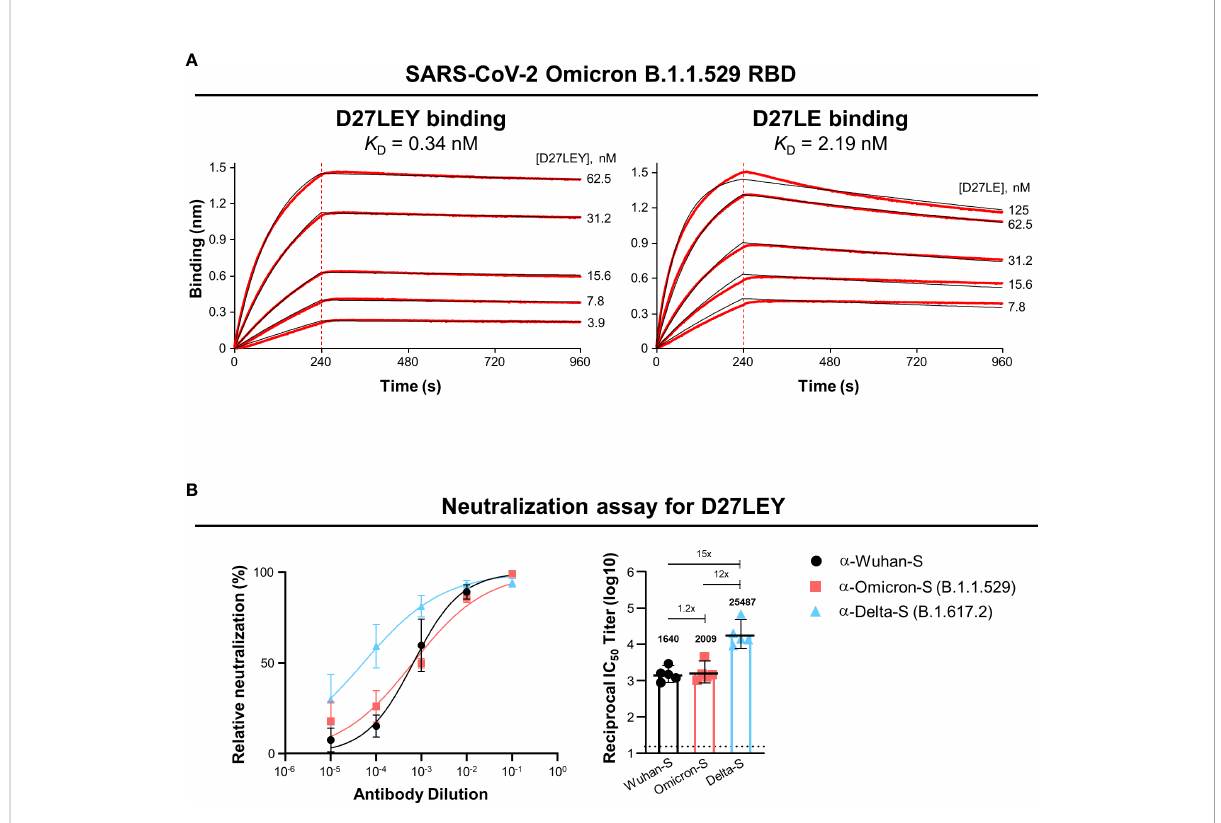
FIGURE 1 D27LEY binds to the Omicron RBD and neutralizes VSV virus pseudotyped with the Omicron Spike protein. (A) Binding af fi nity. BLI was performed at the fi ve indicated concentrations of D27LEY or D27LE. The experiments were performed in technical triplicate with each giving similar results. Representative sensorgrams are shown. The deduced values of the dissociation constant ( K D ) are shown. (B) Pseudovirus neutralization. D27LEY (3 mg/mL) was serially diluted and added to the VSV pseudoviruses bearing the Spike protein of the indicated SARS-CoV-2 strains. The mixture was incubated with 293T-hACE2 cells and the luciferase activity was measured. The GMT values with a 95% con fi dence interval are shown on the right, which correspond to the IC 50 values of 2.13, 1.96 and 0.18 m g/ml of D27LEY antibody for WT, Omicron and